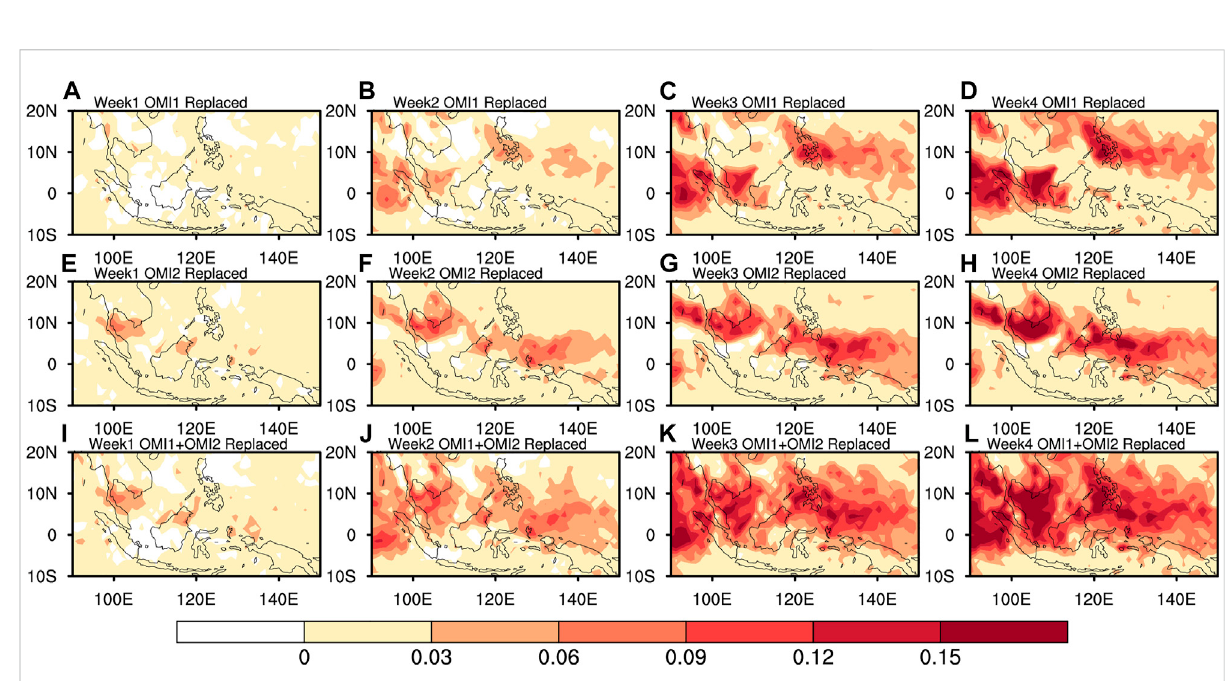
Spatial distributions of enhanced correlations between hindcasts and observed precipitation anomalies at lead times of 1 – 4 weeks after replacing the modeled regression patterns associated with drivers of OMI1 (A – D) , OMI2 (E – H) , and OMI1+OMI2 (I – L) with the observed regression patterns for the ECMWF